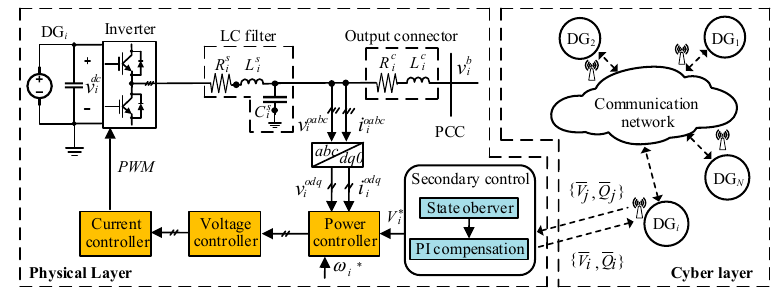
Figure 1. Cyber-physical model of an islanded microgrid.